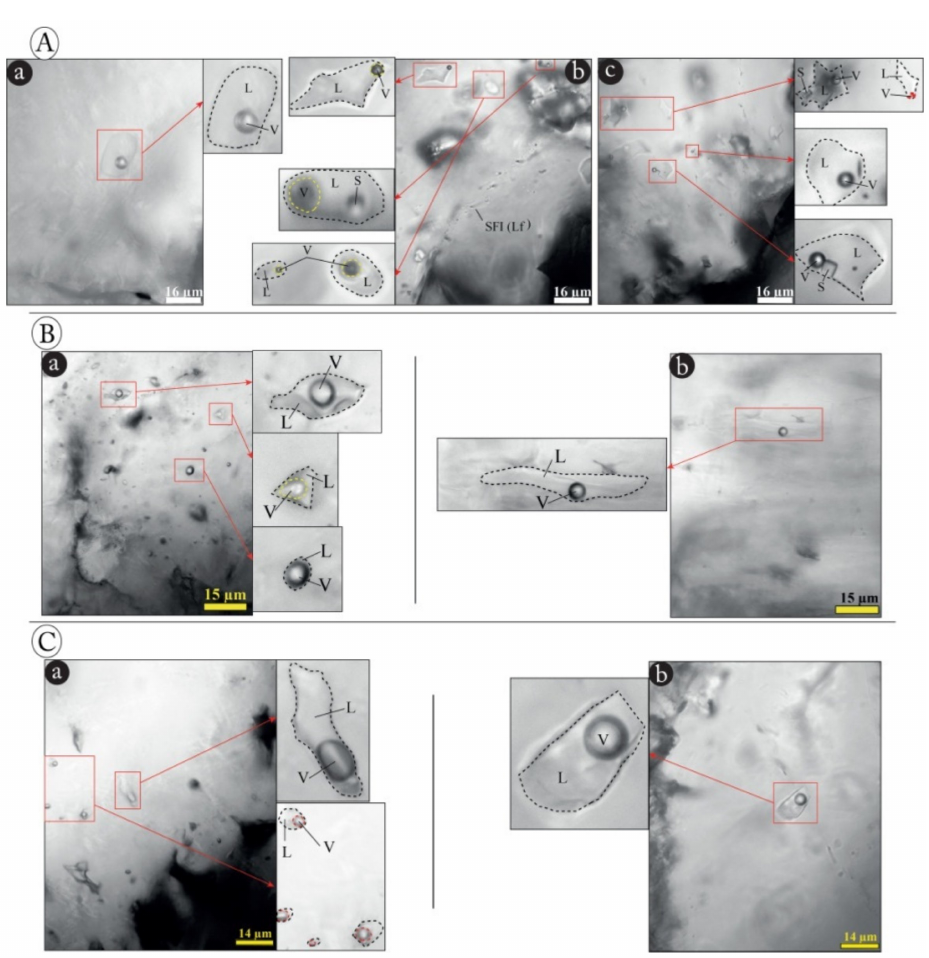
Figure 20. Photomicrographs of typical fluid inclusions in quartz, fluorite, and calcite. ( A (a,b,c)) Secondary biphasic fluid (L and V) L-type inclusions and primary fluid (L, V, and S) S-type en- countered in fluorite in plane-polarized light (PPL); ( B (a,b))biphasic fluid (L and V) L-type and V-type inclusions encountered in quartz (PPL); ( C (a,b)) biphasic fluid (L and V) L-type inclusions encountered in calcite (PPL).L: Liquid; V: Vapor; S: Solid; SFI (Lf): secondary fluid inclusions of the